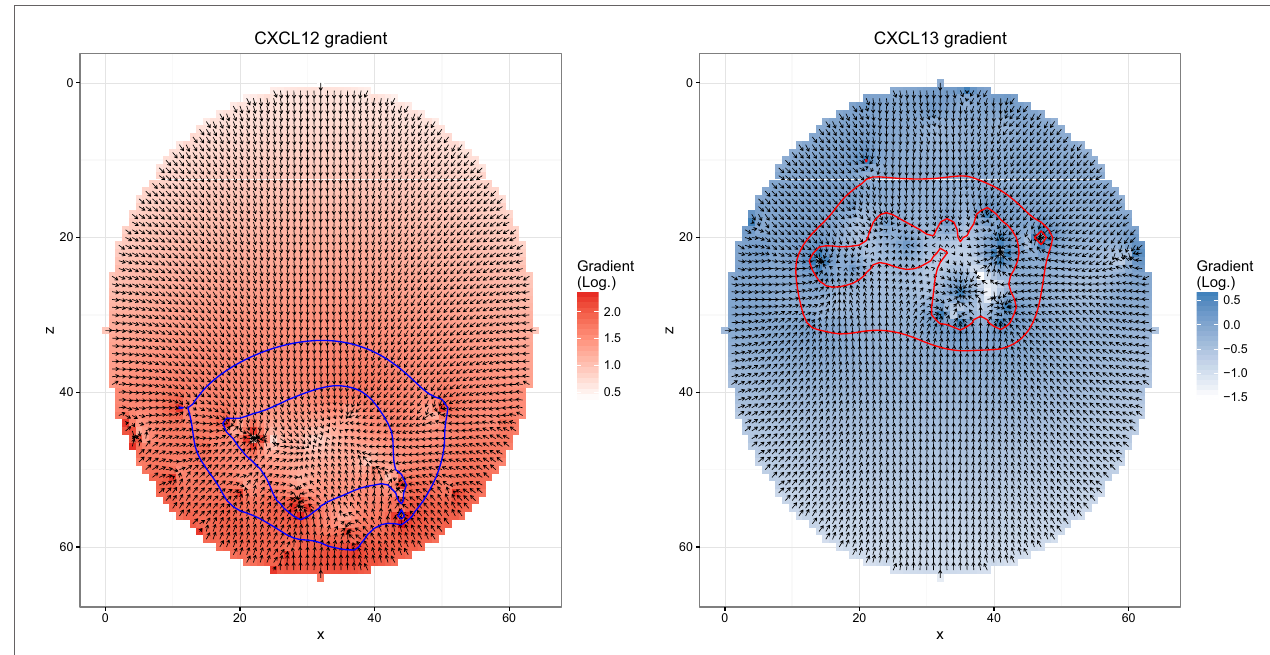
FigUre 1 | chemokine distributions and de-/resensitization . Figures show the chemokine gradient in a two-dimensional cutsection through a germinal center. Gradient directions are indicated by the arrows in the vector field plots, its magnitude is shown by the color. Lines indicate the positions at which chemotaxis desensitization (inner border) and resensitization (outer border)